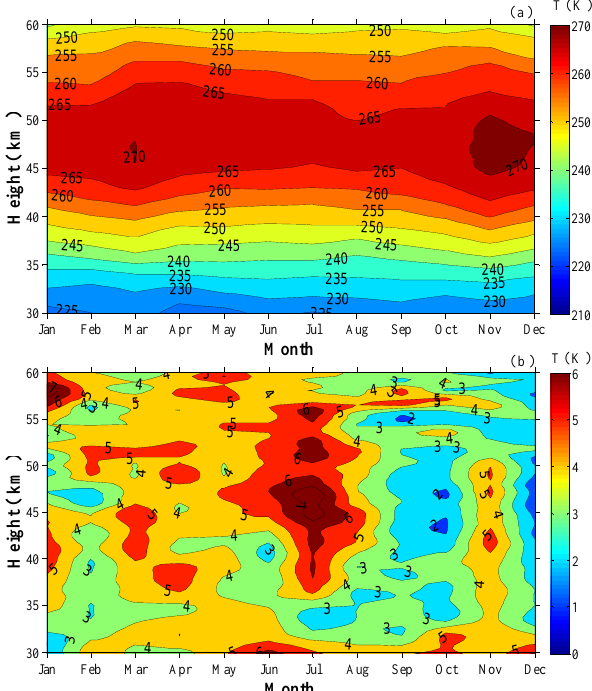
Figure 2: Contour plot of (a) monthly mean temperature and (b) standard deviation obtained 2 Fig. 2. Contour plot of (a) monthly mean temperature and (b) stan- from the LIDAR over the period from 1994 to 2007. 3 dard deviation obtained from the LIDAR over the period from 1994 to